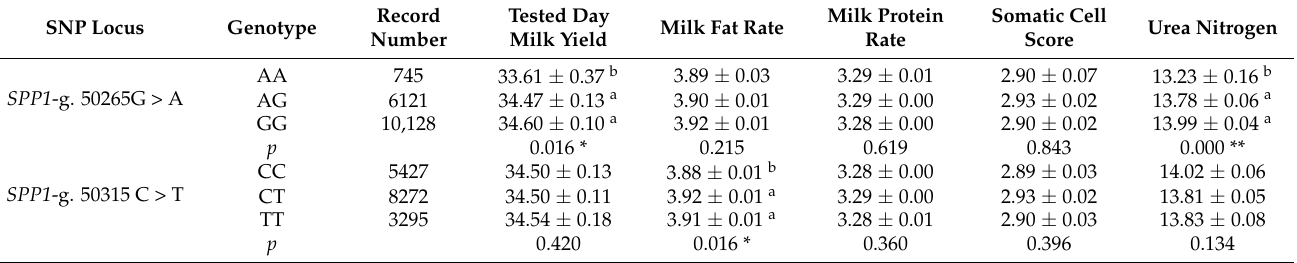
Table 6. Effects of different genotypes of SNPs of SPP1 gene on production performance of Holstein.